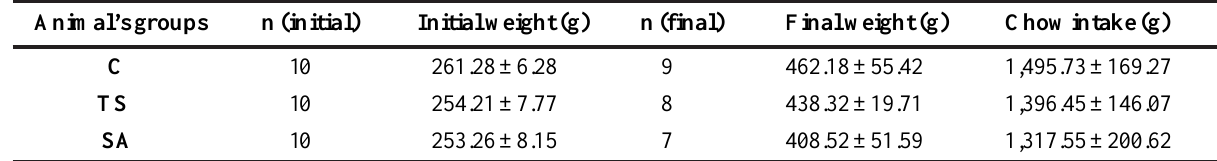
TABLE 1 - Descriptive analyses of body weight and chow intake in the various animal’s groups. Animal’s groups